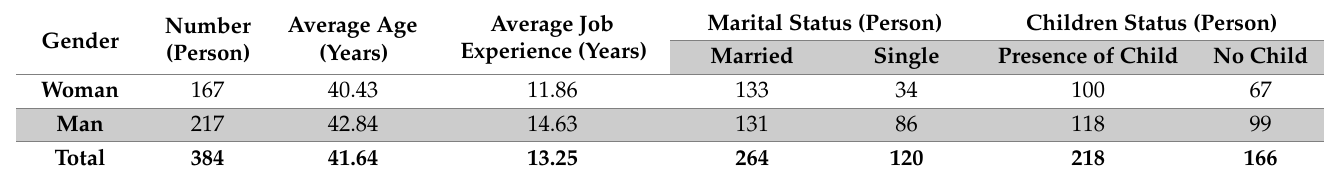
Table 1. A summary of the demographic characteristics of the statistical sample